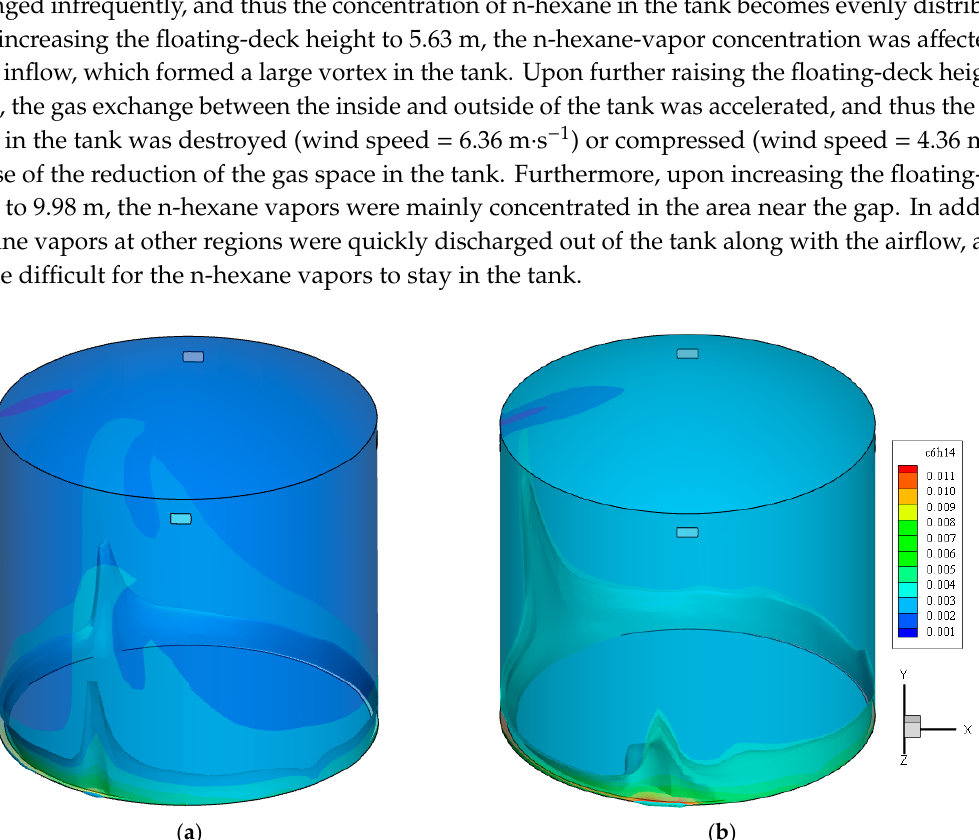
Figure 15. Velocities inside the tank for different floating-deck heights.